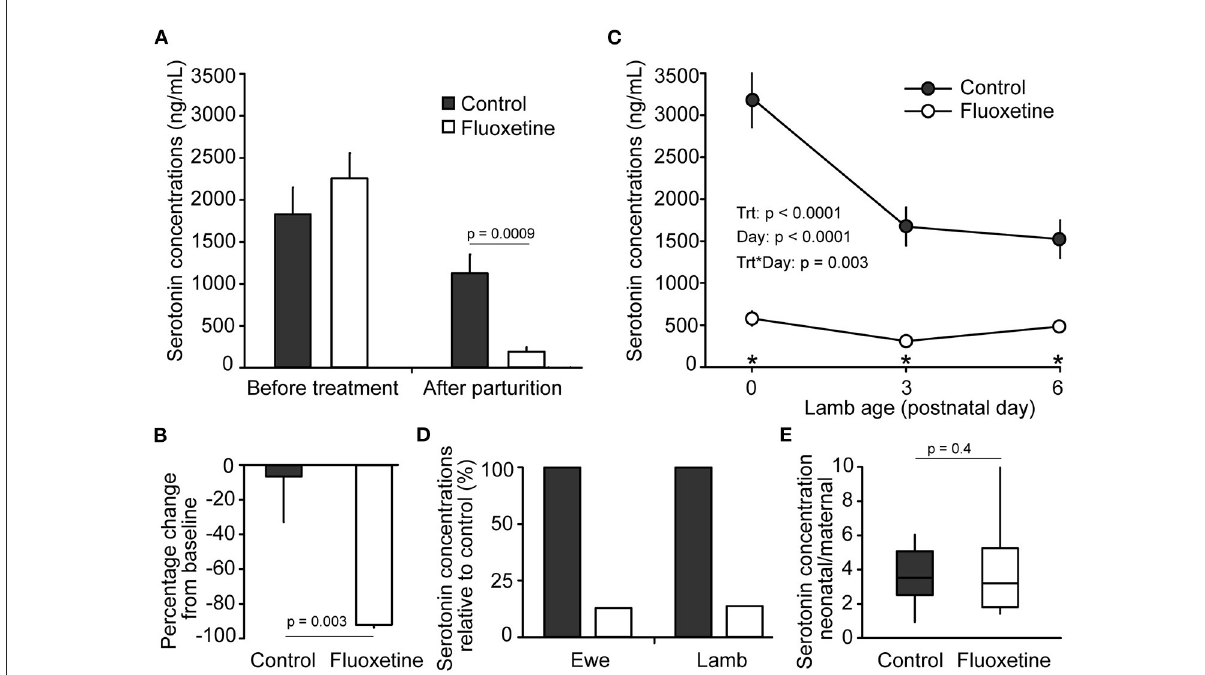
FIGURE1 Serotonin concentrations. (A) Serum serotonin concentrations in ewes before treatment (baseline) and after parturition. Days from beginning of treatment until parturition varied between 26 to 34 days for the control group and 24 to 31 days for the fluoxetine group. (B) Pecentage change in serum serotonin conentrations in ewes between baseline and after parturition. (C) Serum serotonin concentrations in lambs. Blood sample on postnatal day 0 was collected before colostrum ingestion. (D) Serum serotonin concentrations in ewes and lambs relative to control group on postnatal day 0. (E) Neonatal/maternal ratio of serum serotonin concentrations on postnatal day 0; serotonin concentratations in each lamb was divided by serotonin concentrations in their respective dam. * Indicates significant difference between